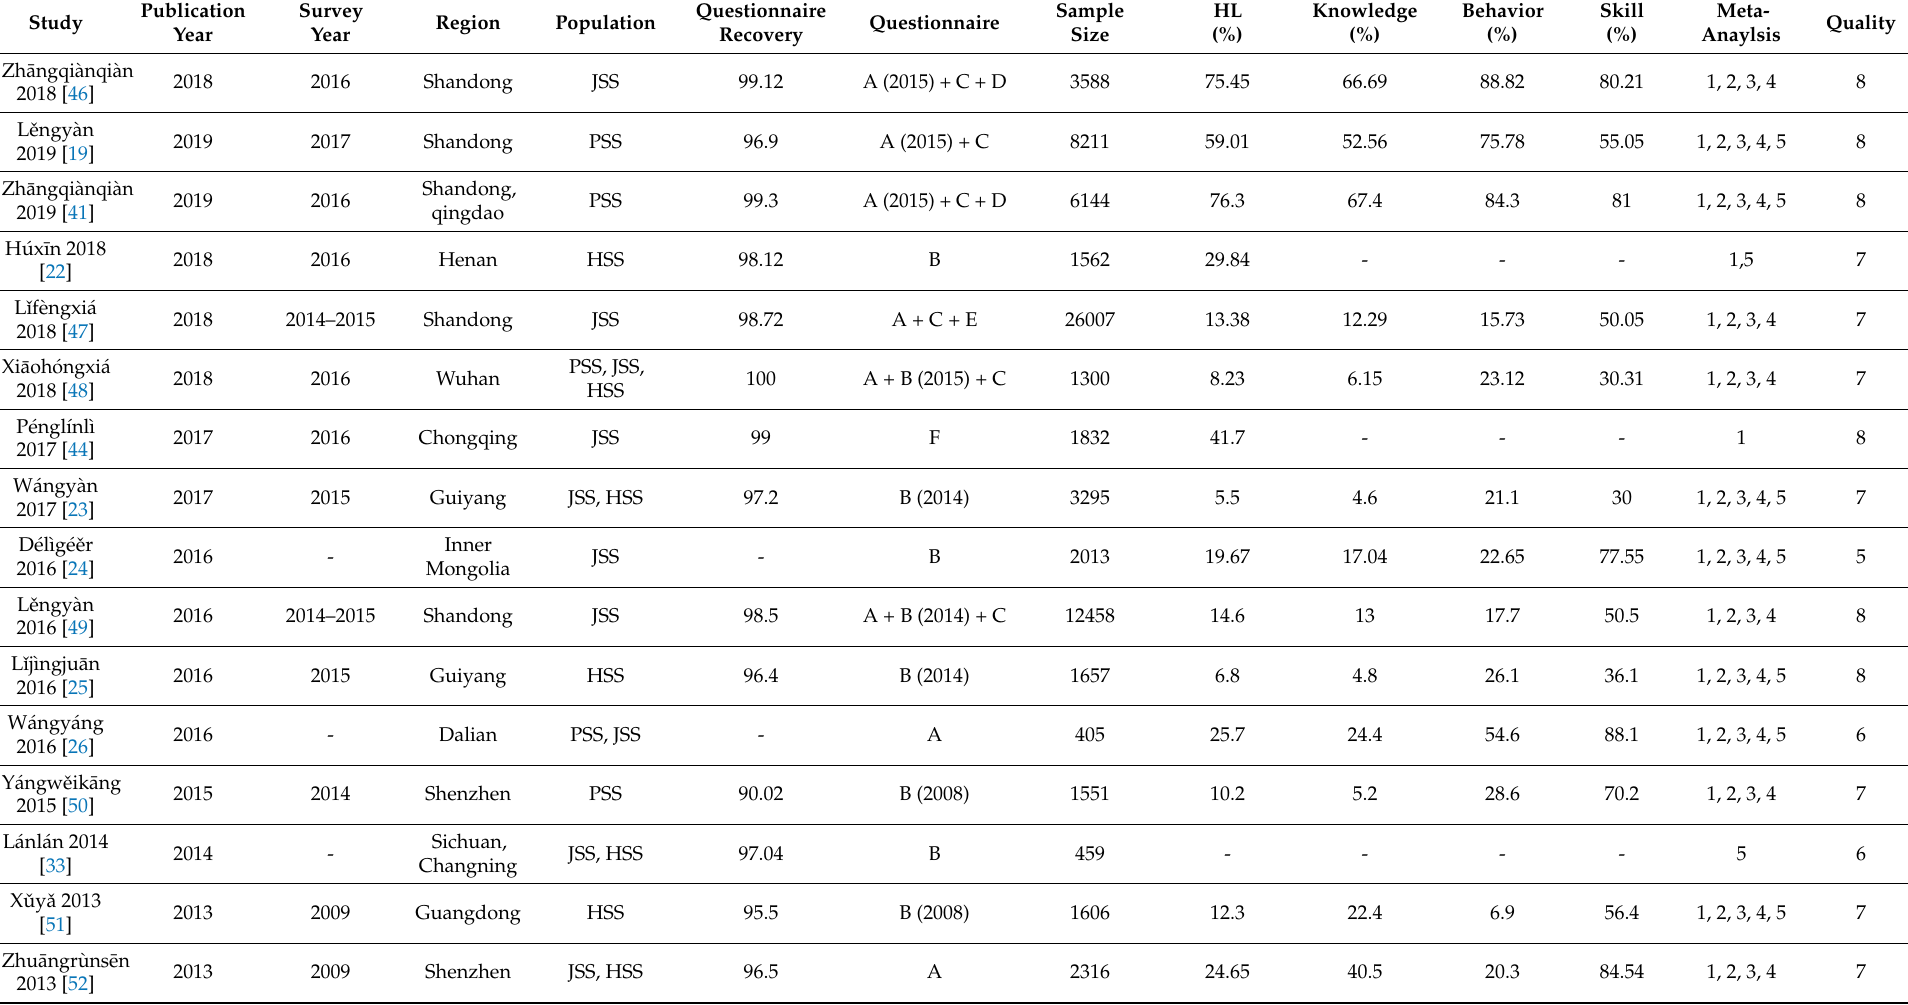
Table 1. Characteristics of the studies